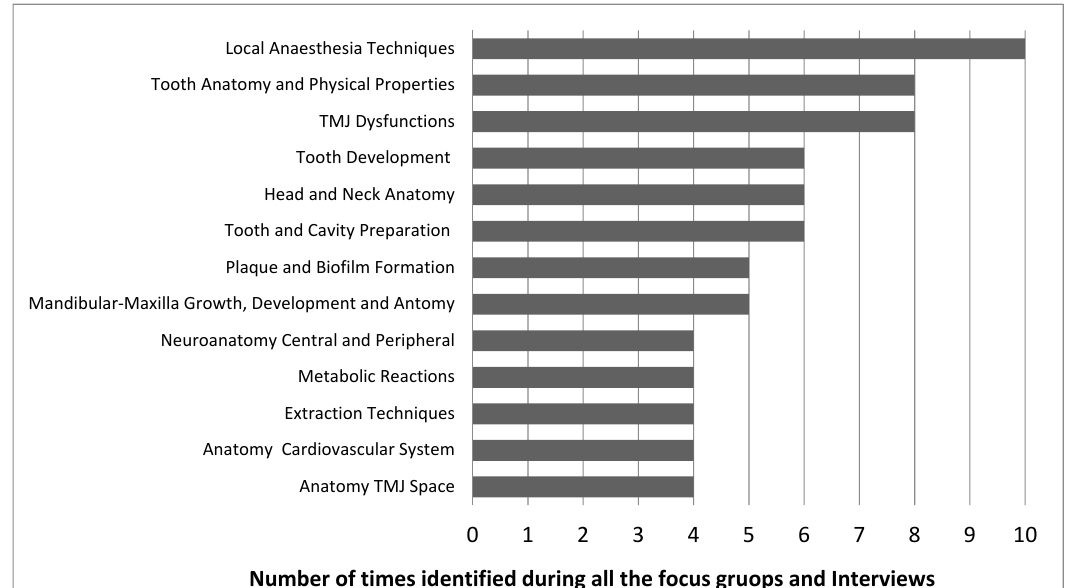
Figure 2. Most recurrent Items from all the focus group sessions and interviews.